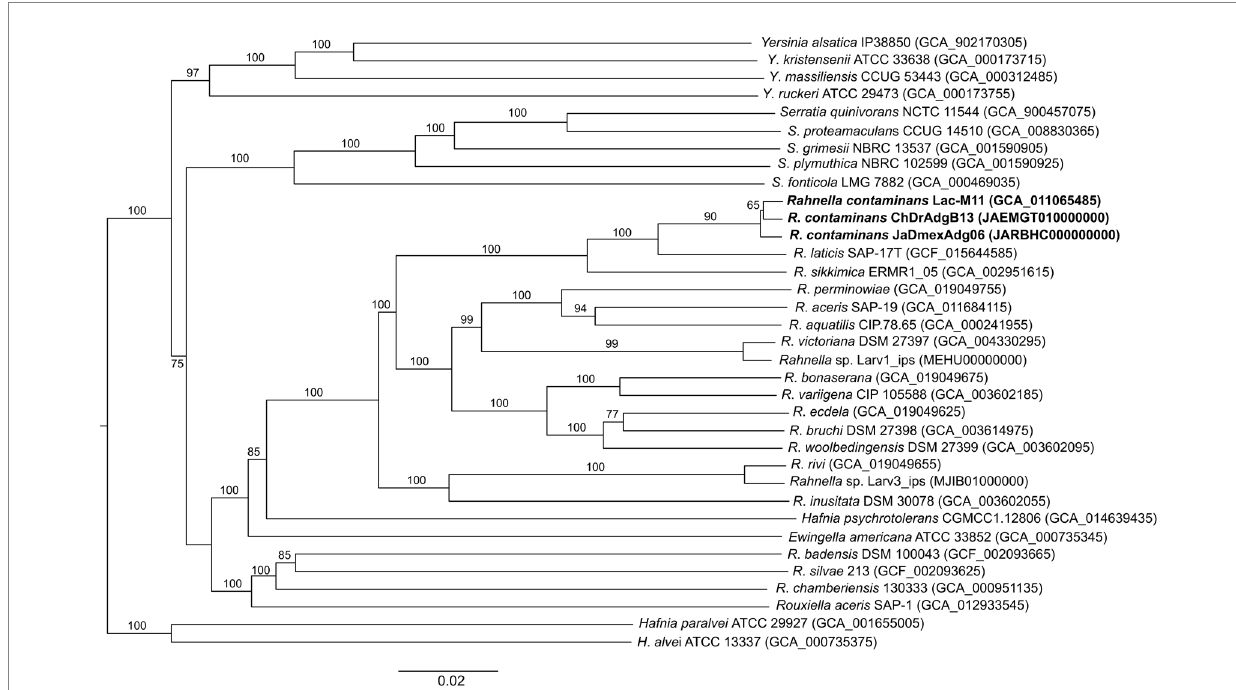
FIGURE 4 Phylogenetic tree of all Rahnella nominal species, including ChDrAdgB13 and JaDMexAdg06 strains. The tree was constructed using GBDP distances among genomes. Bootstrap values >57% are shown at the